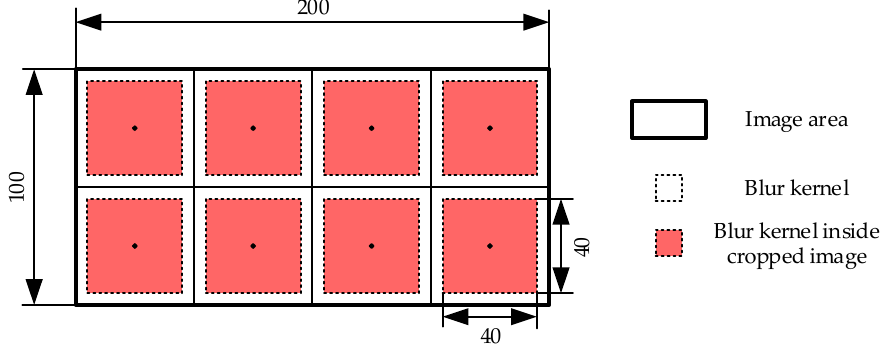
Figure 10. The calculation of the ratio of the blur kernel area in the image with kernel size = 40 × 40.